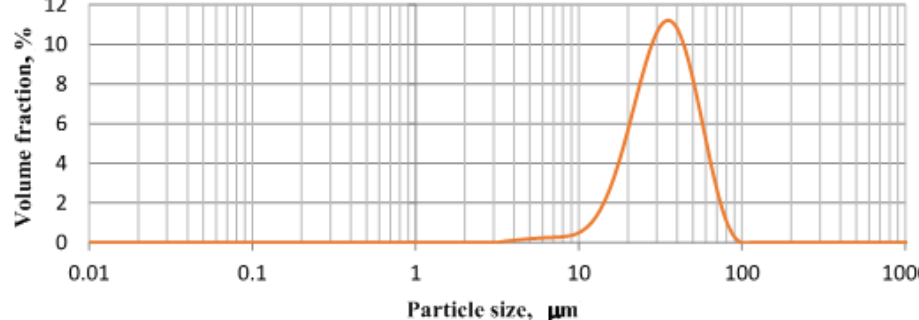
Figure 1. Particle size distribution of titanium powder [25].